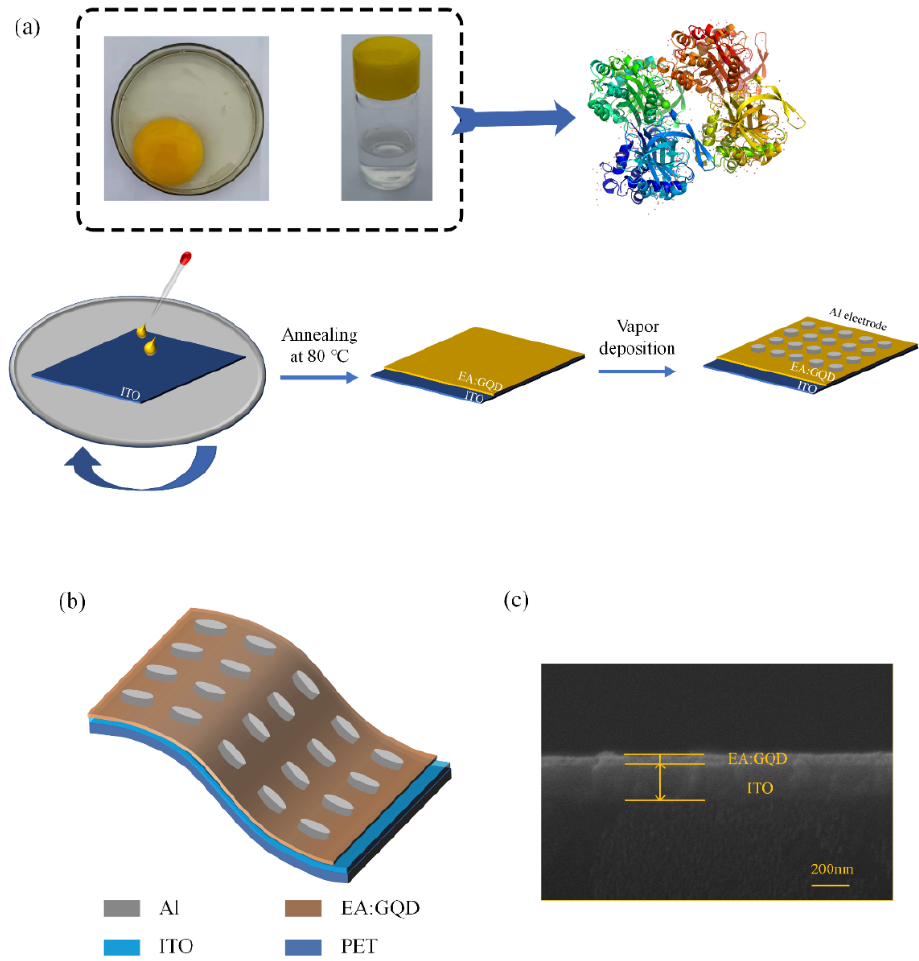
Figure 1. Al/EA:GQD/ITO/PET device: ( a ) fabrication flow chart. ( b ) Structure schematic and ( c ) SEM of the active layer.